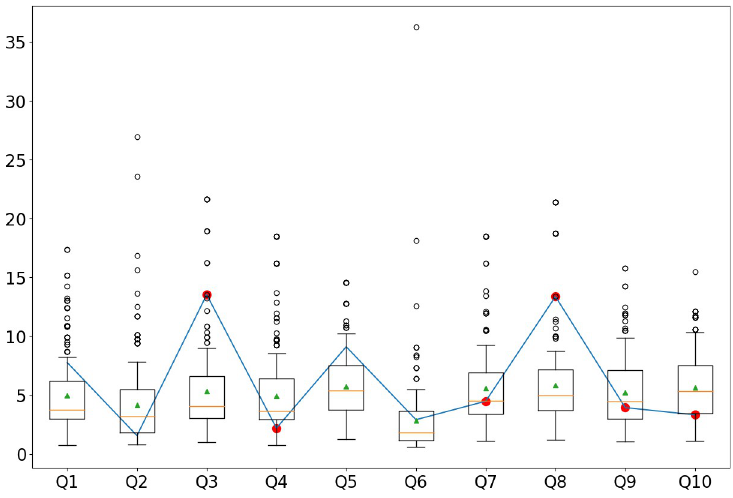
Fig 7. TF-IDF response values for participant 4 (dishonest responses) compared to the distributions of TF-IDF values of honest respondents in the JIHO dataset. Here we report a case where the precision is below the reported average. The red dots indicate the items in which the participant faked. In this specific case, Q1, Q2, Q5, and Q6 received the same response in the honest and dishonest conditions (i.e., the subject did not fake). Of the six dishonest responses, two were correctly identified. Q4, Q7, Q9, and Q10 were not reported as faked. The total accuracy is 6/10.